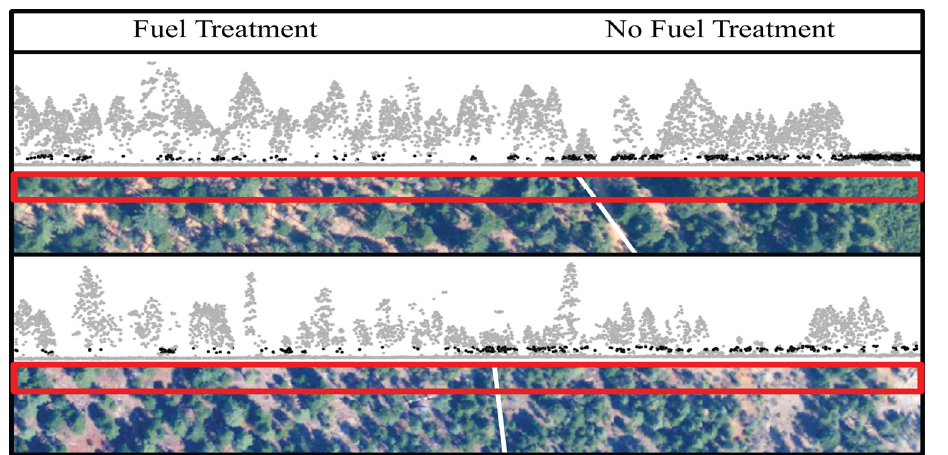
Figure 6. Two pairs of transect images, each showing a 300 m by 10 m transect of LiDAR points across a treatment boundary, paired with the corresponding aerial image; the LiDAR has been transformed to show an even ground elevation and points 2–4 m from the ground are shown in black; the aerial image shows the transect outlined in red and the treatment boundary in white; transects were chosen to present different levels of canopy density (cover varied between 48% and 78% in the upper image pair and 18% and 61% in the lower pair) and the visual ambiguity of treatments in the aerial image (treatment is apparent in the aerial image of the upper transect, but difficult to discern from the aerial image of the lower